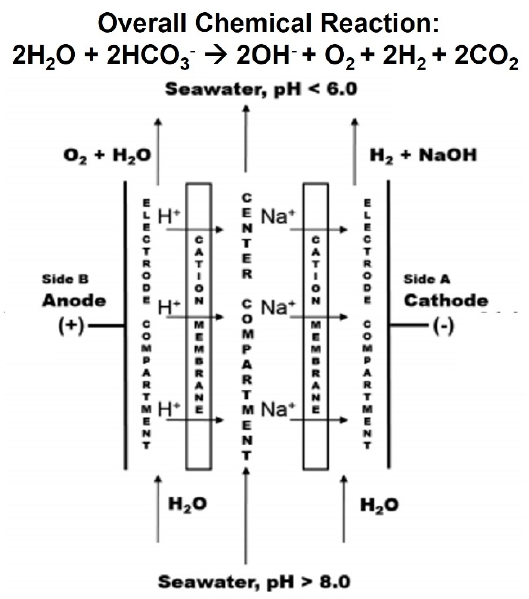
Figure 5. Reprinted (adapted) with permission from [72]. Copyright (2017) American Chemical Society.